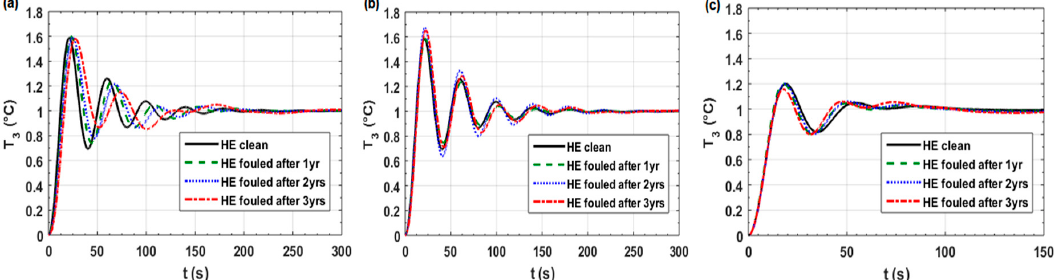
Figure 17. Closed-loop step responses (case no. 2) under fouling conditions of the HE models: without adjustment ( a ) after adjustment ( b ) and after adjustment of optimal ( c ) PID tuning parameters. Table 6. Values of the control-quality indices for used sets of the PID parameters in different periods of operation (case no. 2).